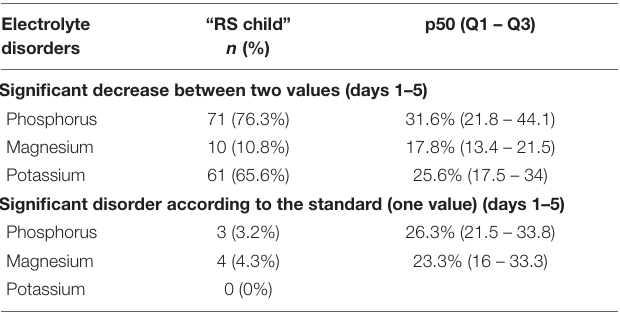
TABLE 2 | Electrolyte disorders of phosphorus, potassium and magnesium in the children identified with a probable Refeeding Syndrome.